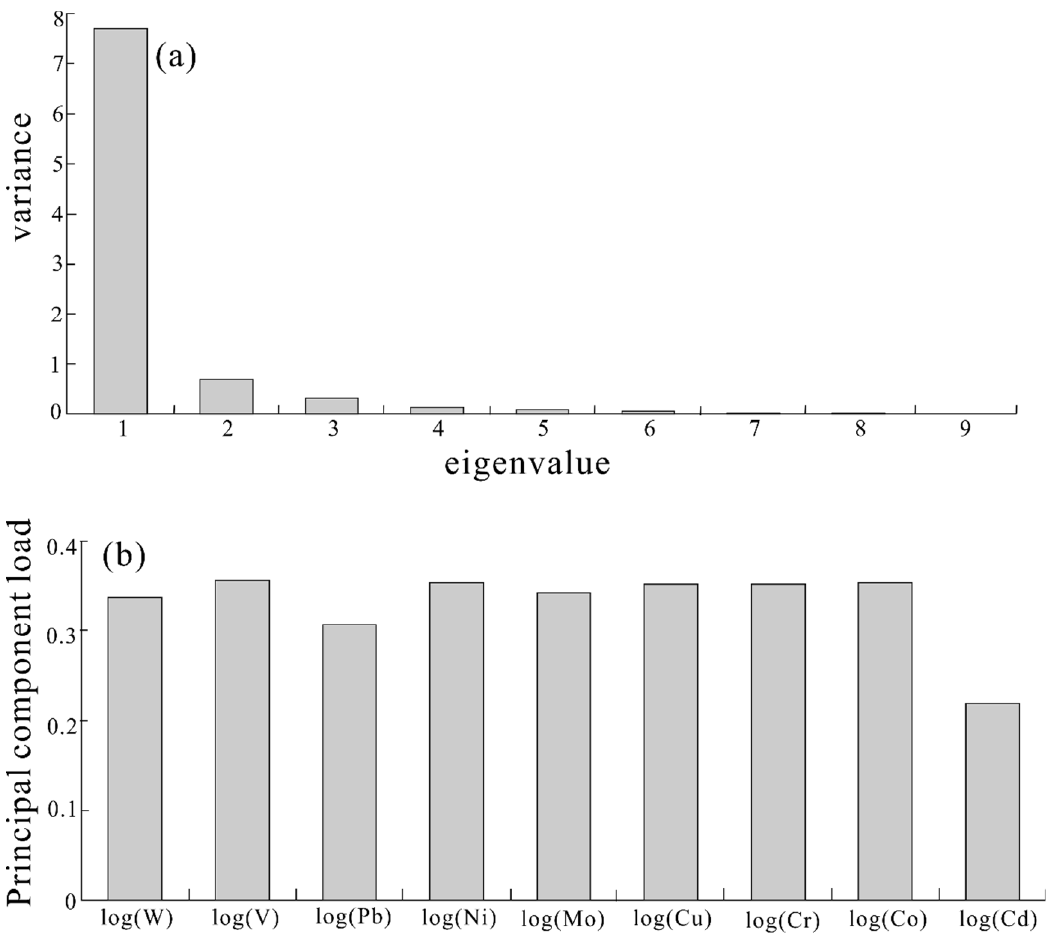
Figure 6. Principal component analysis of log-transformed values of W, V, Pb, Ni, Mo, Cu, Cr, Co, and Cd. ( a ) Eigenvalue distribution; ( b ) load in the first principal component, i.e., the contribution of each element to the first principal component.